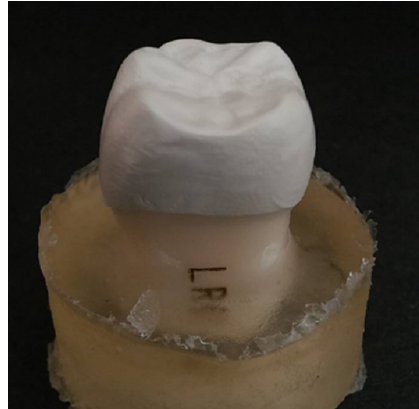
Figure 2. PEEK dental crown was cemented on artificial tooth abutment and embedded in epoxy for compression test.